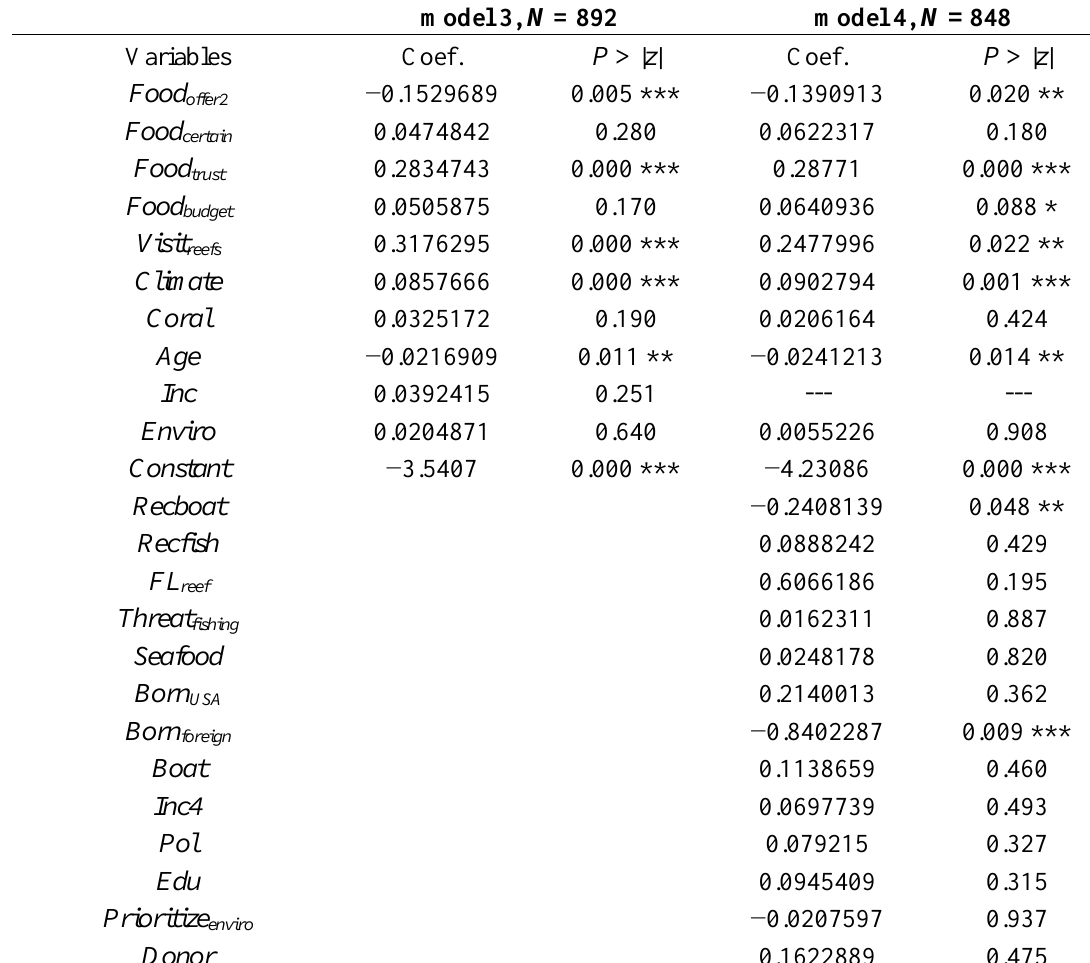
Table 5. Logit models for local seafood